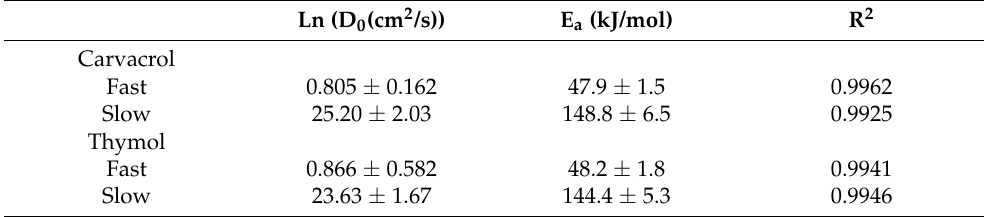
Figure 12. Arrhenius-type plots of the fast and slow diffusion coefficients for the release of thymol and carvacrol in order to estimate the activation energies of the processes. Table 5. Estimated activation energies and pre-exponential factors for the fast and slow diffusion process during release of thymol or